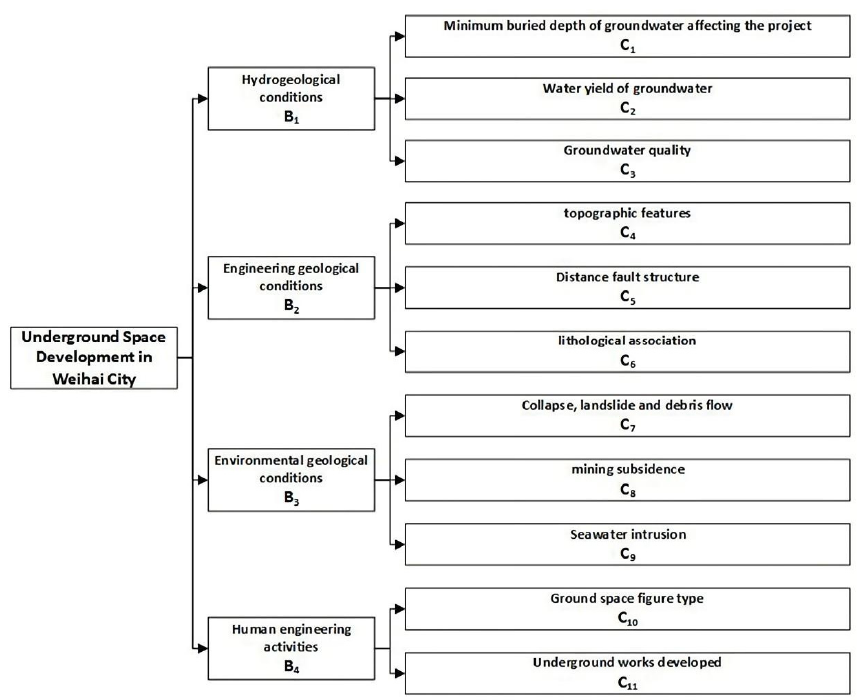
Figure 3. Evaluation index system of underground space resource development suitability in Wei- hai city.